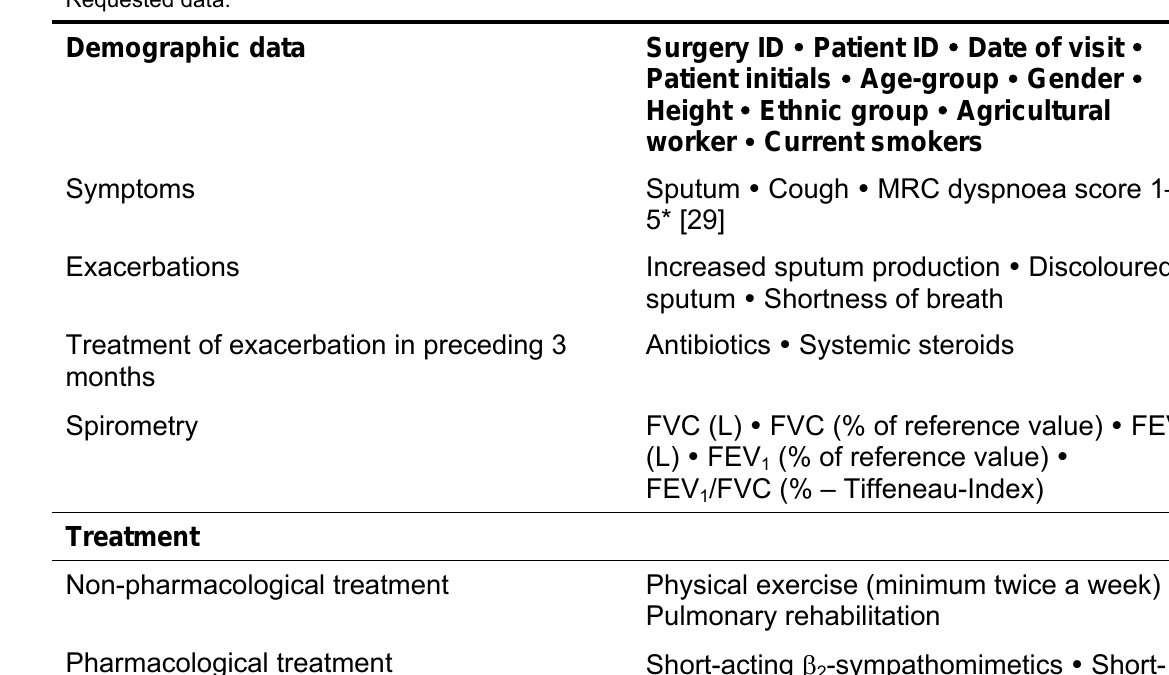
Table 1 Requested